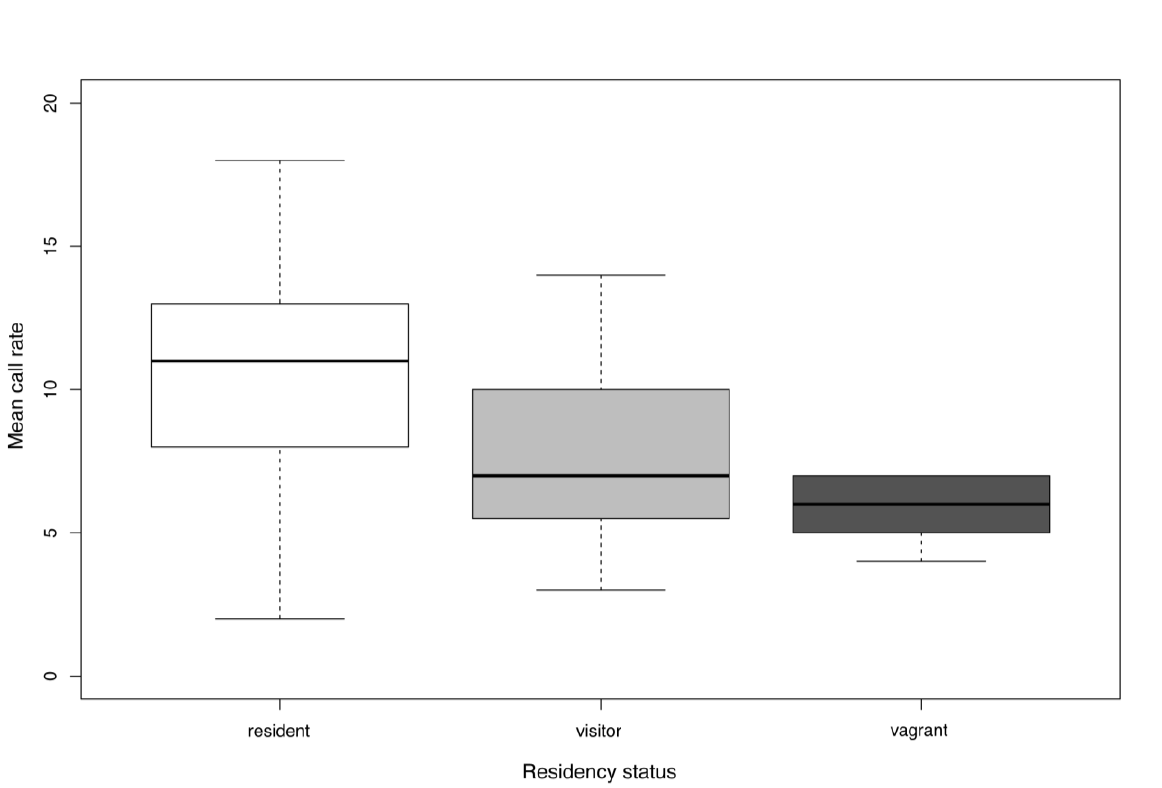
Figure 3. Differences in mean call rate with respect to residency status of six females. Boxplots show interquartile ranges with median (bold line), whiskers represent the minimum and maximum of all the